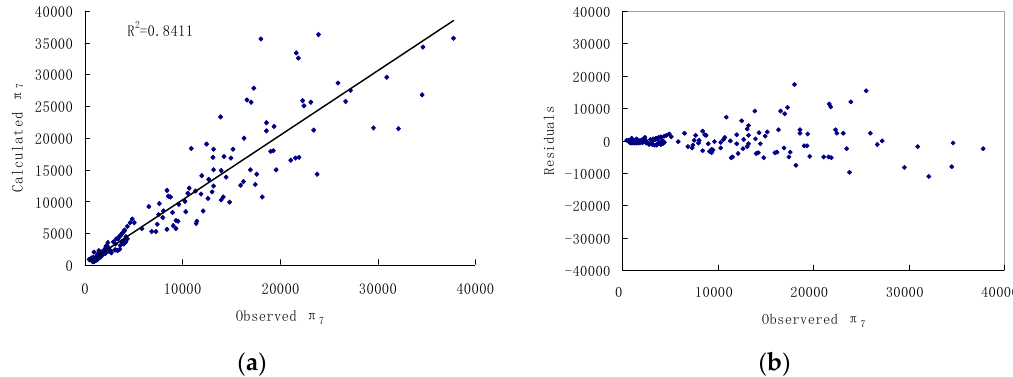
π , the calculated value from Equation (6), ( a ) and residues ( b ). Figure 3. The measured value of Figure 3. The measured value of π 7 , the calculated value from Equation (6), ( a ) and residues ( b 7 Table 6. Statistical parameters comparison of calculated Δ H from equations and measured Δ H , Pa .